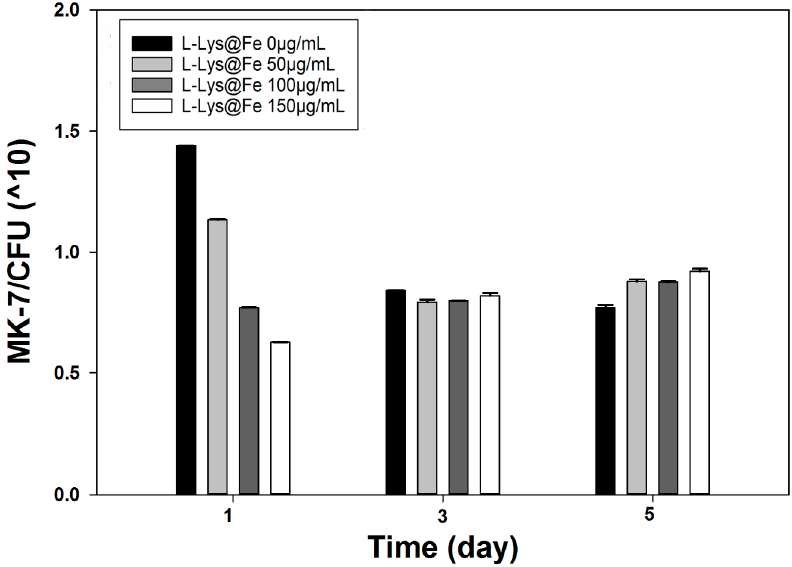
Figure 9. MK-7 specific yield at different at L -lysine-IONs concentrations.